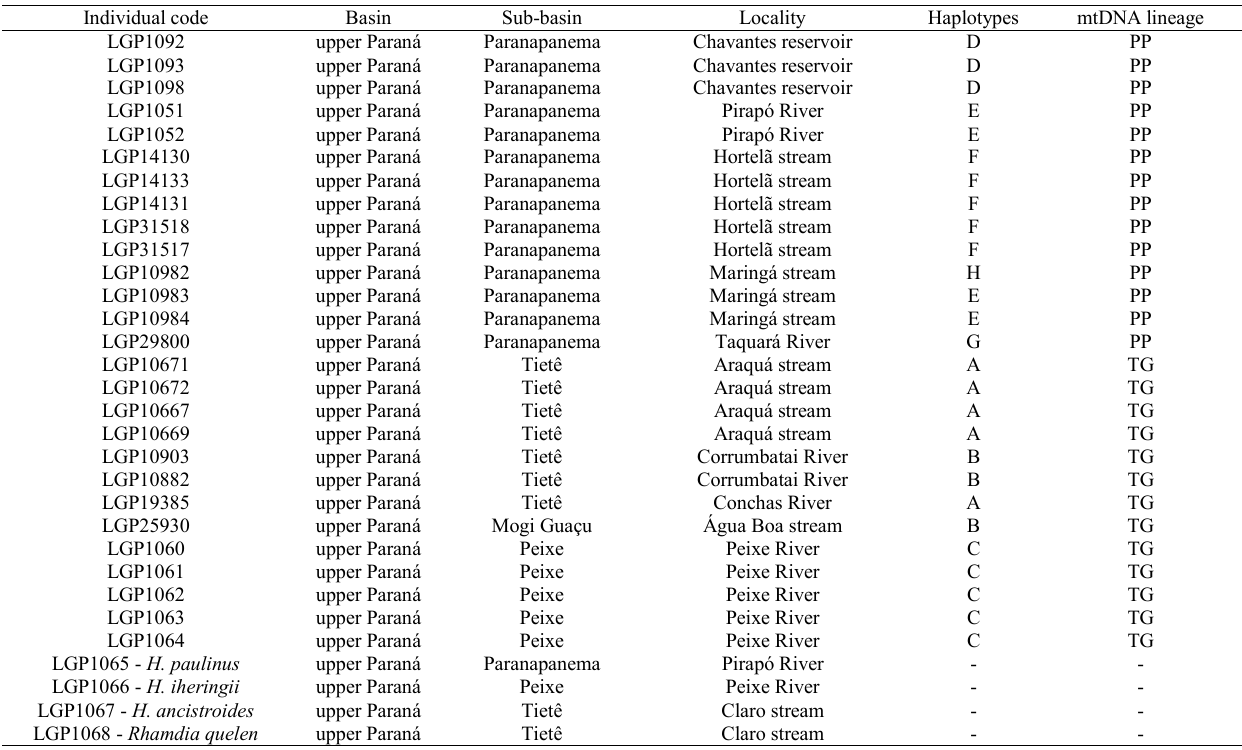
Table 1. Identification of Hypostomus strigaticeps specimens collected, respective collection points at the upper Paraná River basin and their haplotypes and mtDNA lineage. Individual